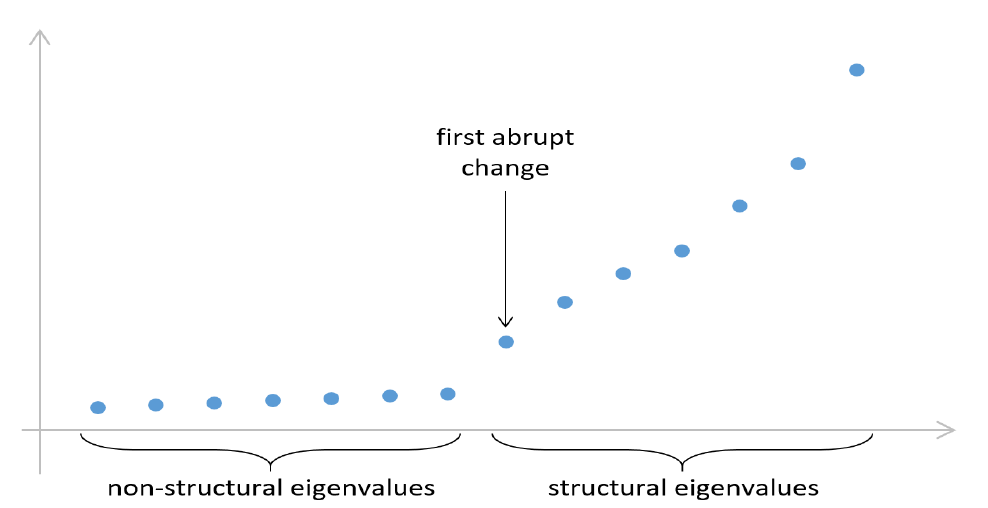
Figure 12: The abrupt change after the non-structural